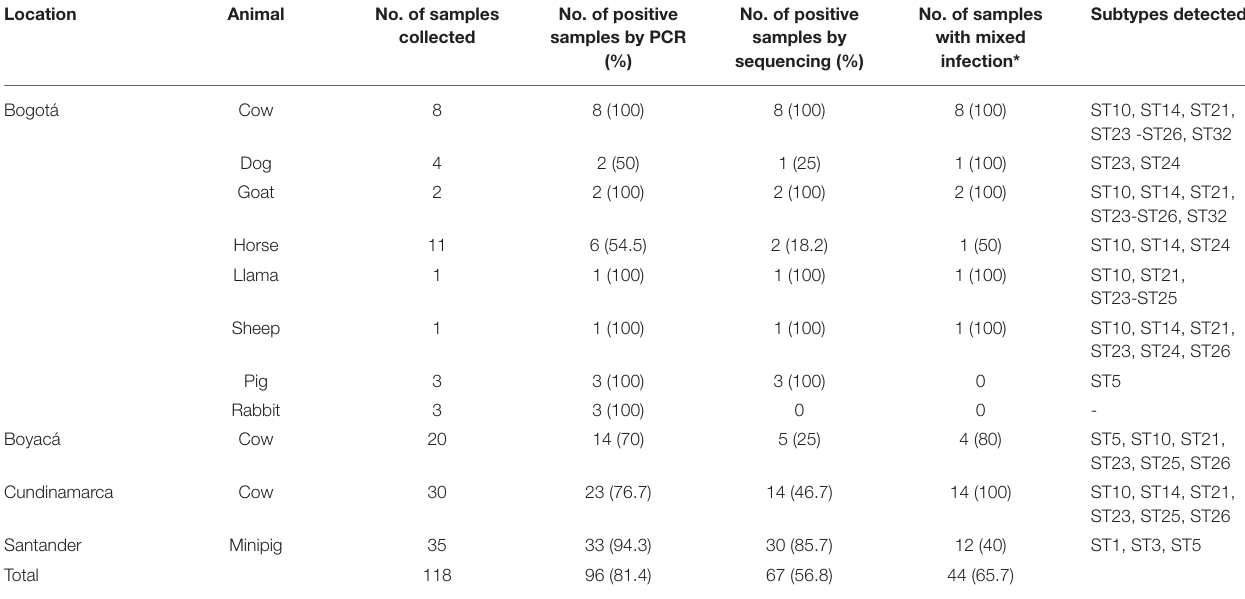
TABLE 1 | Occurrence of Blastocystis in domestic animals from different locations in Colombia. Location Animal No. of samples Bogotá